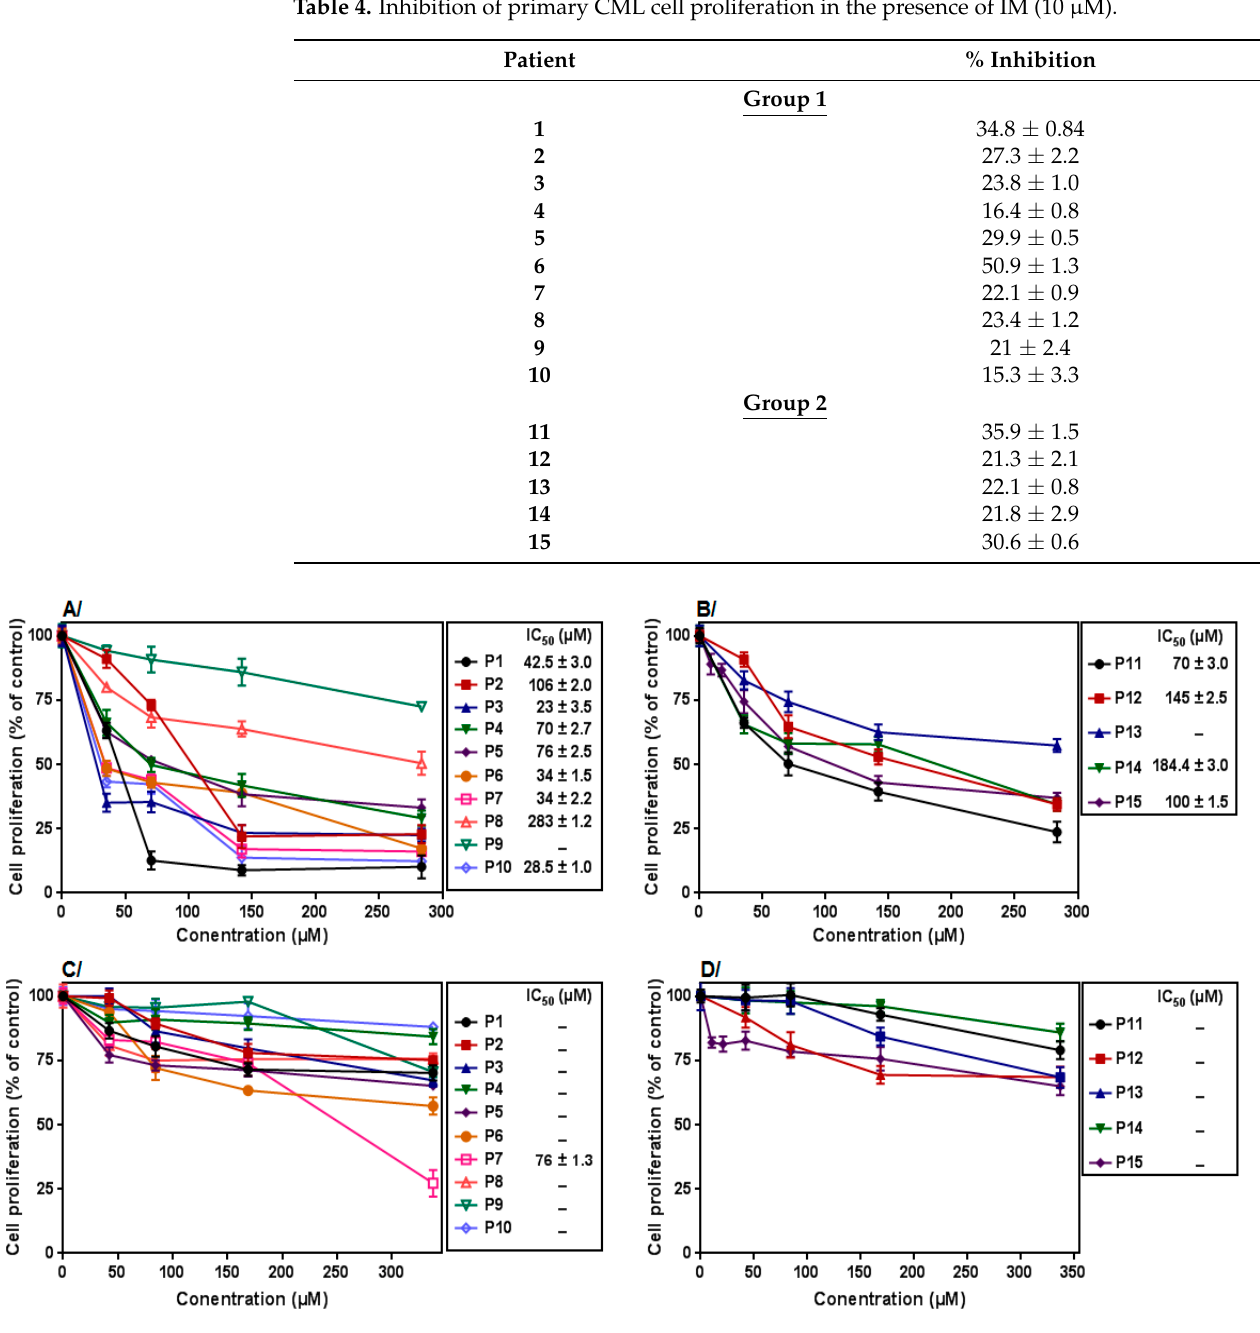
Table 4. Inhibition of primary CML cell proliferation in the presence of IM (10 µ M).